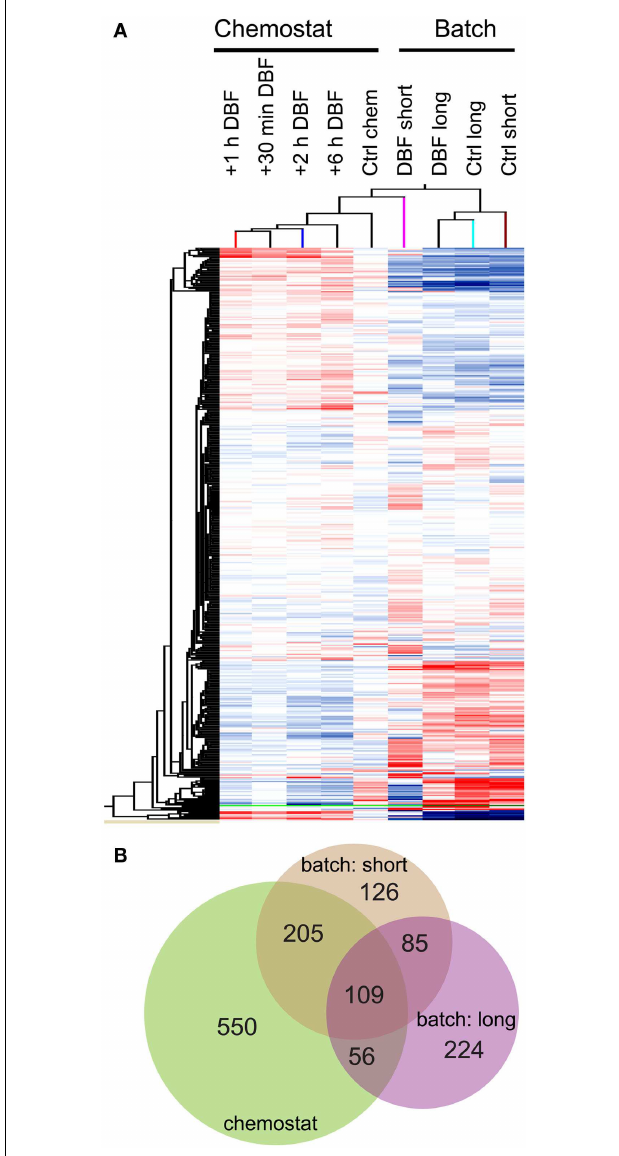
FIGURE 1 | (A) Hierarchical clustering of RW1 gene expression over all conditions generated by GENESPRING GX. Short refers to the short DBF exposure in batch cultures, Long to cells grown in batch cultures on DBF, and Chemostat refers to the transient exposure to DBF in continuously grown cultures. Color code: red, increased expression; blue, decreased expression. (B) Venn diagram (Hulsen et al., 2008) grouping the genes differentially expressed in the DBF exposure experiments compared to PHE-control conditions. Numbers represent genes exclusive for one condition, while the numbers in the intersections represent those occurring between two or more